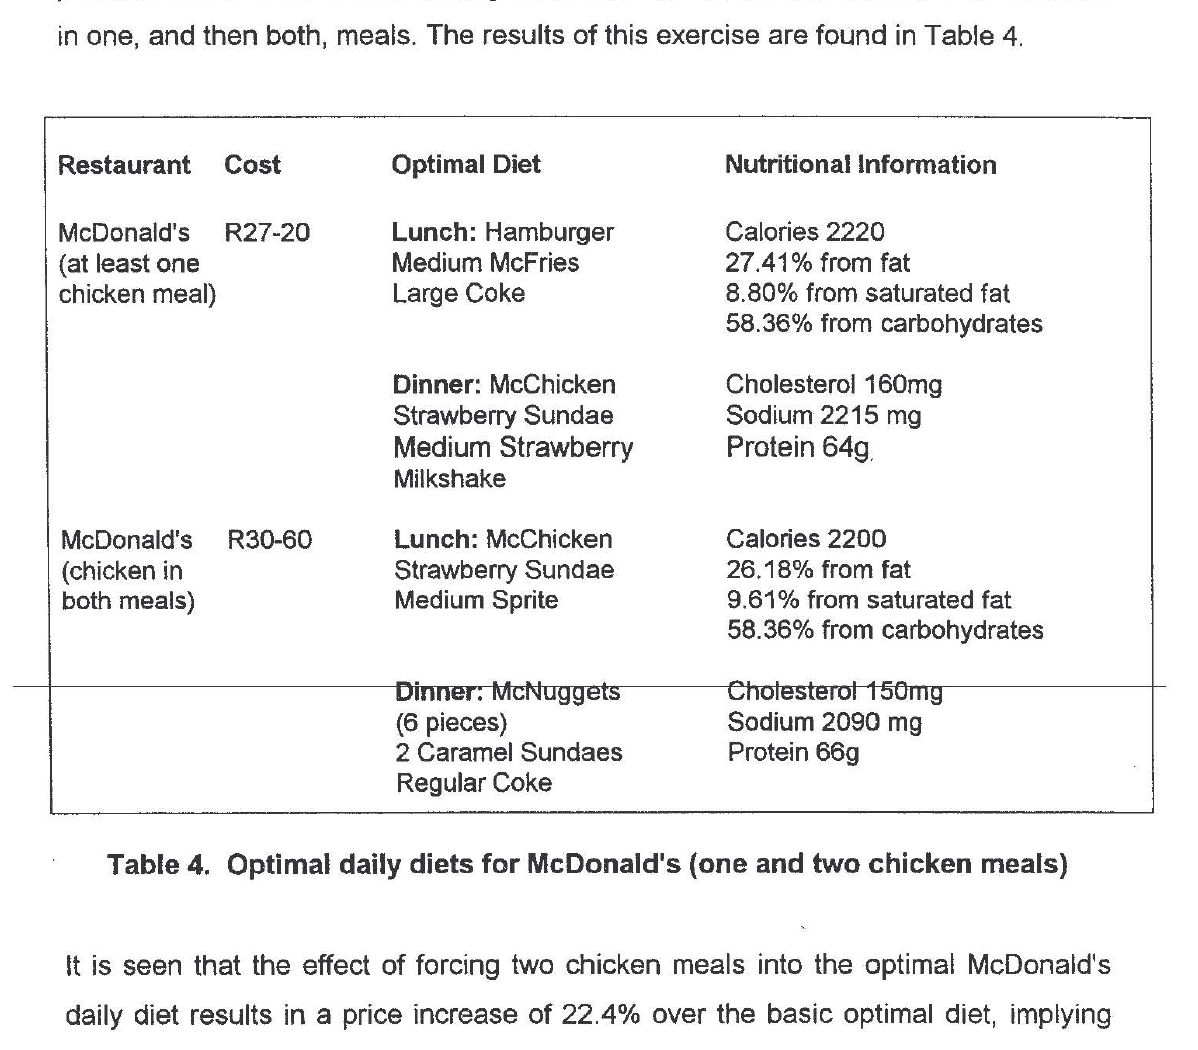
lt is seen that the effect of forcing two chicken meals into the optimal McDonald's daily diet results in a price increase of 22.4% over the basic optimal diet, implying that chicken in a fast-food menu is a more expensive component than ground beef or fish. However the McDonald's two-chicken-meals diet is still significantly cheaper than the best near-optimal KFC diet (R30-60 versus